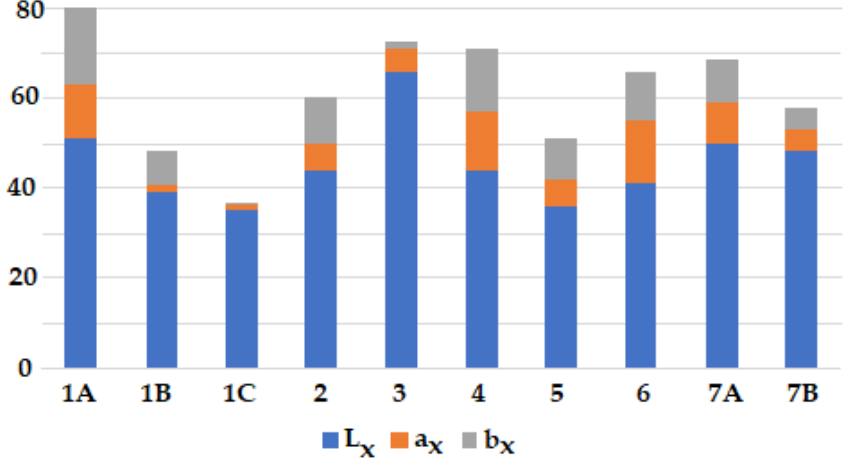
Figure 6. The chromatic parameters of the pottery samples .